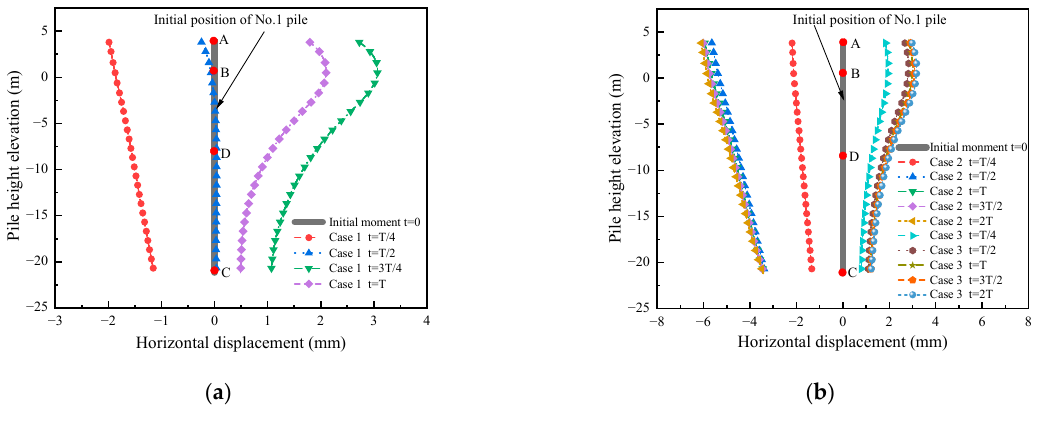
drop of the water level, which is the most unfavorable case among the three cases.